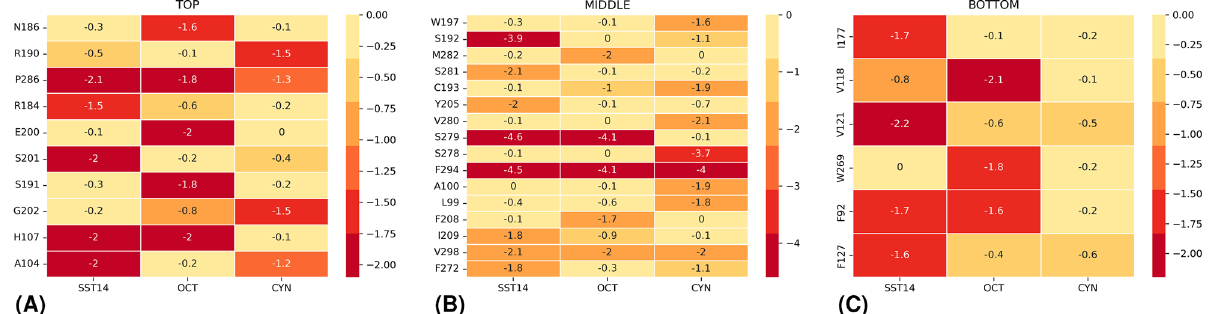
Figure 5. Partial contribution of SSTR2 residues to the MM-GBSA binding free energy (kcal/mol) for SST14, OCT and CYN. Values are reported in kcal/mol according to the pocket regions: ( A ) top, ( B ) middle, ( C ) bottom and ordered according to their spatial localization. Only residues in which at least one contribution reached an energy value of − 1.0 kcal/mol are reported. The cells are colored from the highest to the lowest values of the binding free energy (i.e., from yellow to red).